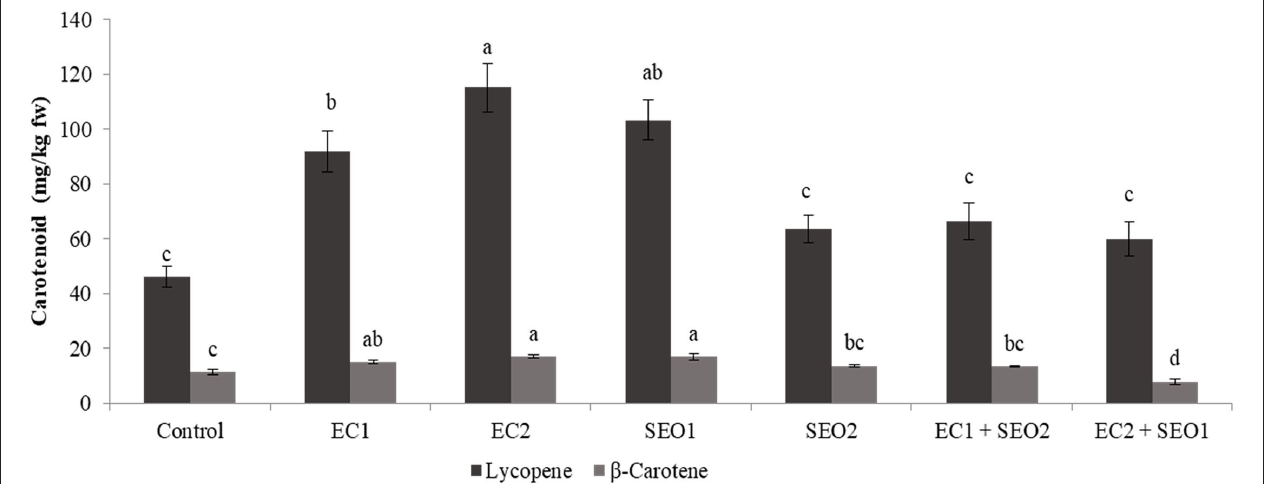
FIGURE 3 | Lycopene and β -carotene content (mg/kg fw) of tomato fruits under control (C, 0.4 dS/m), saline (EC1, 3.5 dS/m; EC2, 7 dS/m), spent engine oil stress (SEO1, 0.5%; SEO2, 1%) and the combinations (EC1/SEO2, 3.5 dS/m EC/1% SEO; EC2/SEO1, 7 dS/m EC/0.5% SEO). Values are means ( n =